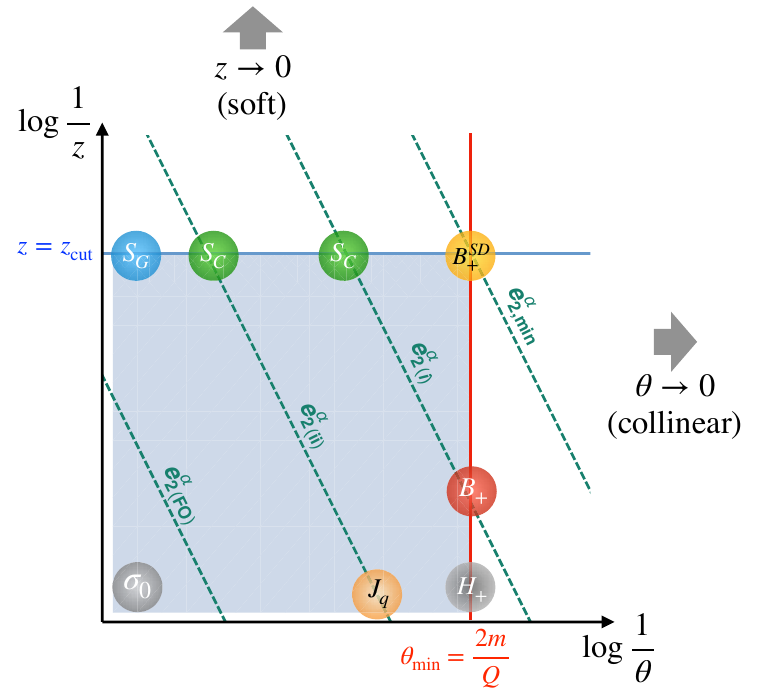
Figure 2 . Phase space in z, θ and associated modes, for the case α > 1 (in this plot, α = 2), spectrum for values represented by e ( α ) is to be contrasted with figure 1. In this case, the e ( α ) 2 2( ii ) insensitive to the quark mass, and the collinearity of the jet modes is determined solely by e ( α ) 2 itself. In this region, the factorization is the same as for massless parton groomed jets, giving rise . For smaller e ( α ) values represented by e ( α ) , the factorization is the to the massless jet function J q 2 2( i ) same as in figure